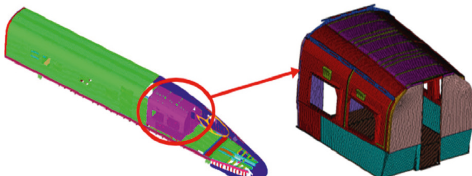
Figure 9: Finite element model of the vehicle body and the sightseeing area.